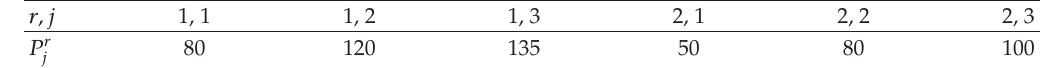
Table 2: Passenger demands (cid:6) unit: person times (cid:7) .